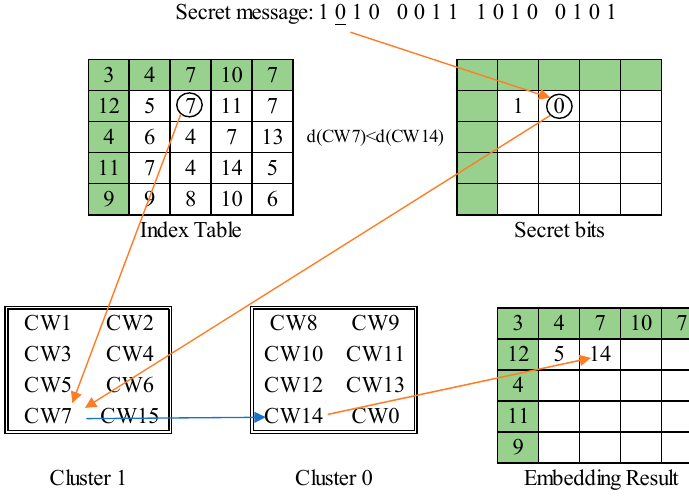
Figure 9. Embedding example 2: mismatched case.